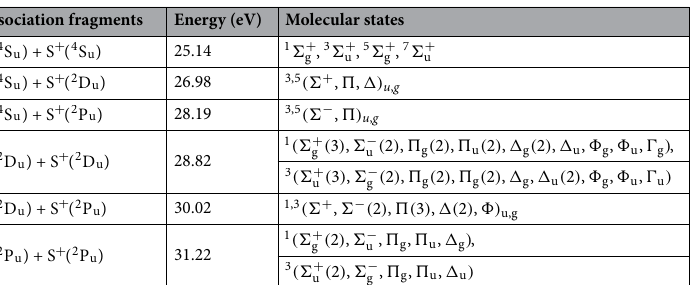
+ + fragments in their ground and excited states Table 1. Computed dissociation limits for S 2 2 leading to two S 4 S 2 D 2 P 2 3 p 3 configuration. The lowest asymptote is located experimentally as u , u and u arising from the 3 s 25.14 eV above the vibrational ground state of neutral S 2 17,21 . The adiabatic double ionisation energy of S 2 is calculated as 26.31 eV, lying 1.18 eV above the lowest asymptote. The reference energy is that of S 2 (X 3 (cid:31) − g ) v = 0 .